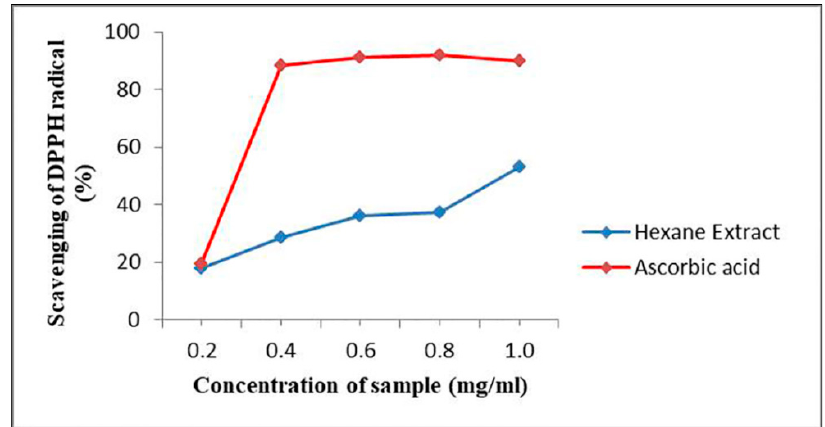
Figure 9. Scavenging effects of hexane extract of G. triuniae NFCCI 4873 on DPPH radical.